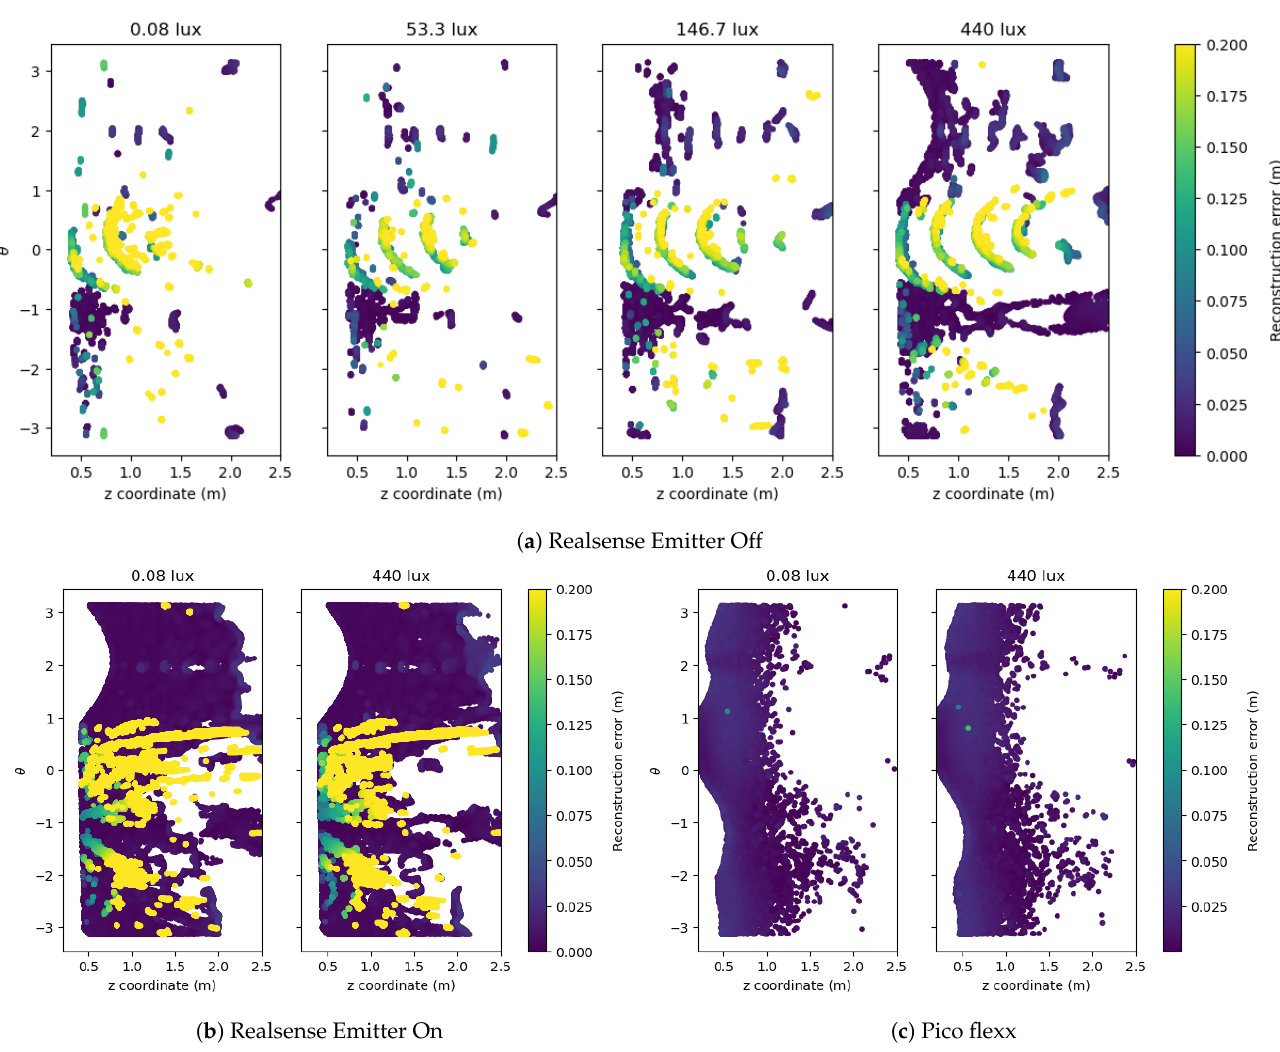
Figure 14. 2D projection of the cloud-to-mesh distance from the three sensor configurations in the outdoor setup. The color coding of the cloud represents the cloud-to-mesh distance. If points overlay each other on the 2D projection, the point with the largest cloud-to-mesh distance is plotted on top and is thus fully